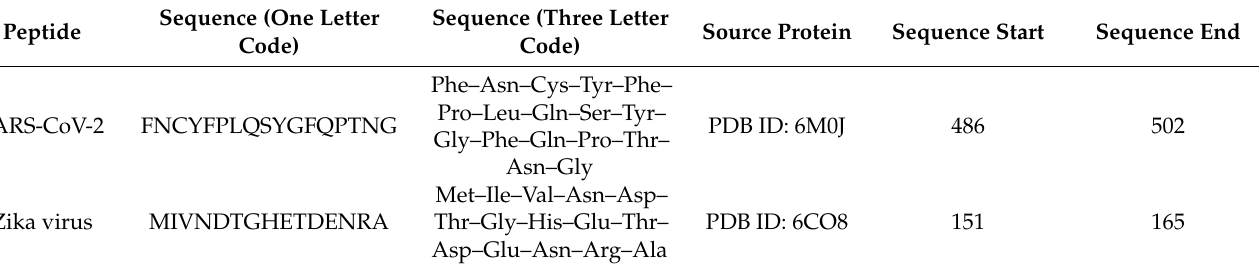
Table 1. Information about the selected